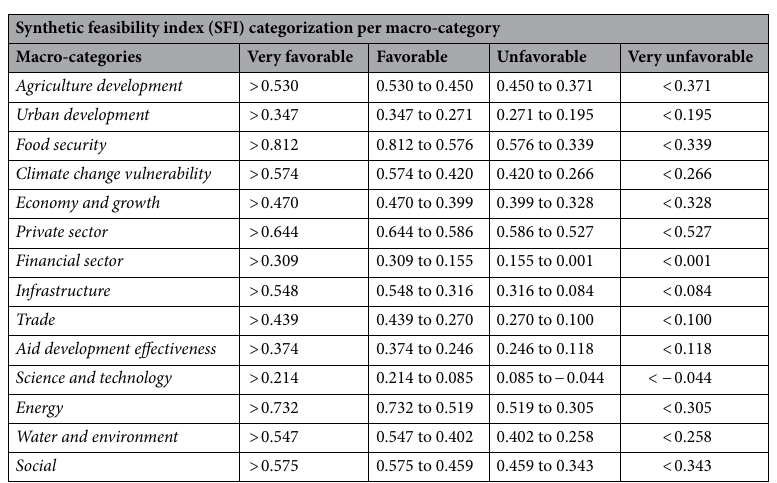
Table 1. Synthetic feasibility index (SFI) categorization per